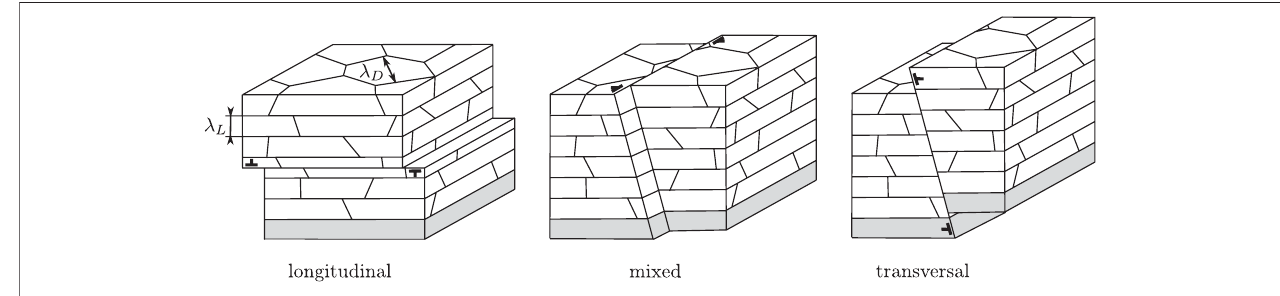
FIGURE 2 | Schematic illustration of the morphological deformation modes of the lamellae. The morphological classi fi cation was introduced in Lebensohn et al. (1998). λ